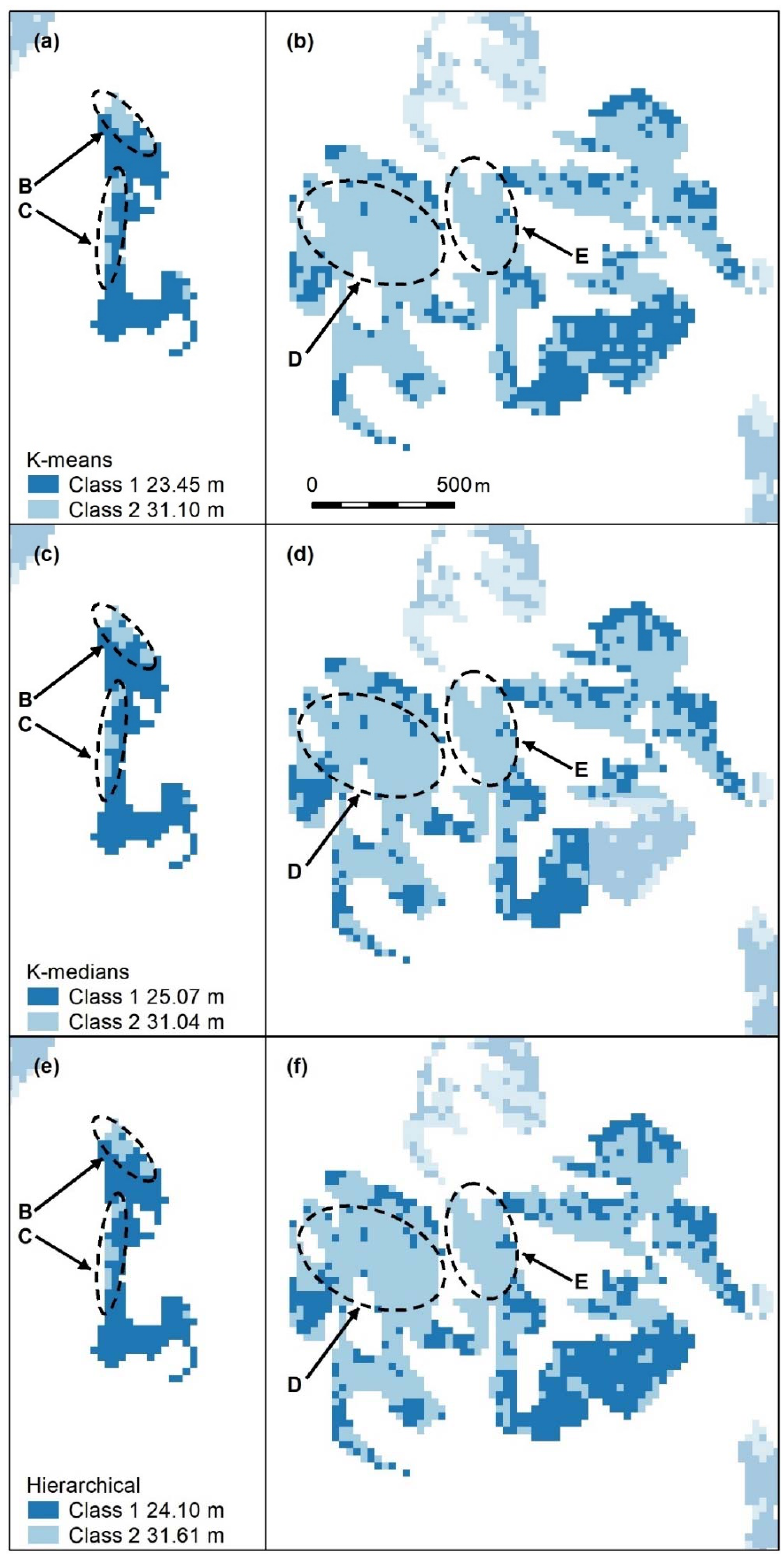
Figure A12. Nonspatial algorithm (K-means, ( a , b ), K-medians ( c , d ), hierarchical ( e , f )) cluster maps with 2 classes. Letters B–E indicate areas of higher canopy. Features B and C ( a , c , e ) are captured, but the areal extent of D and E ( b , d , f ) is not as well-defined as in Figure A11 Panel scores: K-means = 6, K-medians = 6, and Hierarchical =